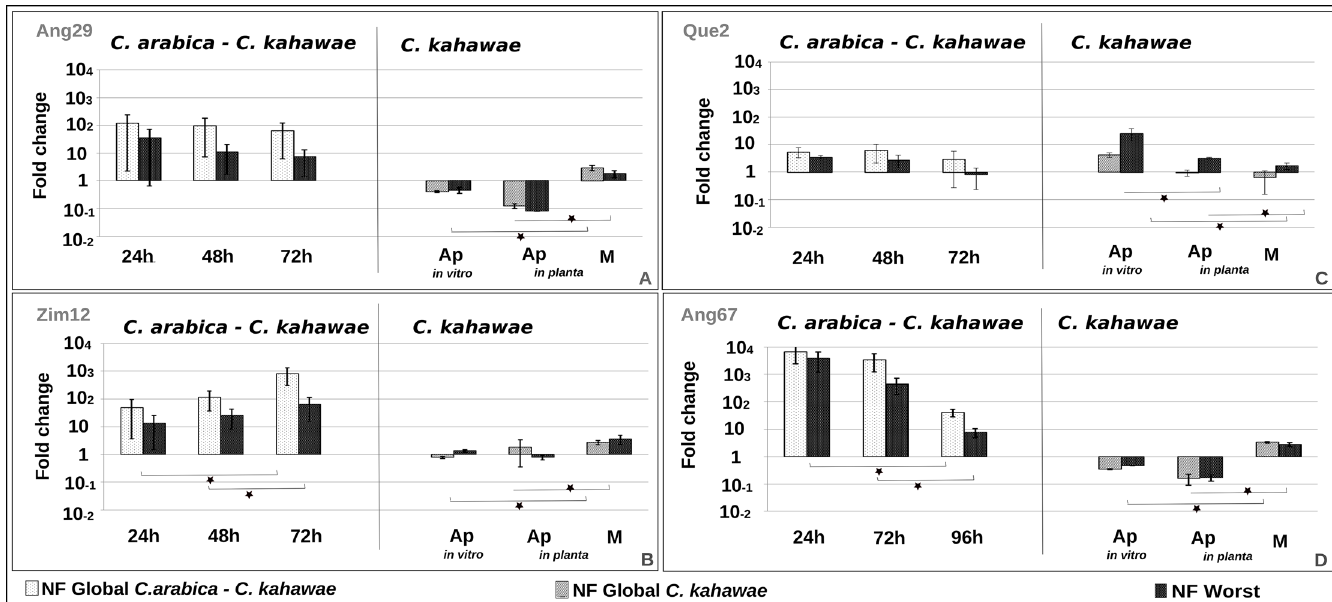
Fig 4. Relative quantification of cat2 expression using the best and the Worst normalization factors (NF). Expression profiles are presented per isolate (Ang29 (A), Zim 12 (B), Que2 (C) and Ang67 (D)), during the early stages of infection process and growth (Ap: Appressoria; M: Mycelium). The C . arabica – C . kahawae samples were normalized with NF Global C . arabica — C . kahawae interaction ( PP1; Act; ck34620) and NF Worst ( ck20430; ck48742; ck36020) , while the C . kahawae samples were normalized with NF Global C . Kahawae ( PP1; Act; ck20430 ) and NF Worst ( ck34620; ck36020 ).